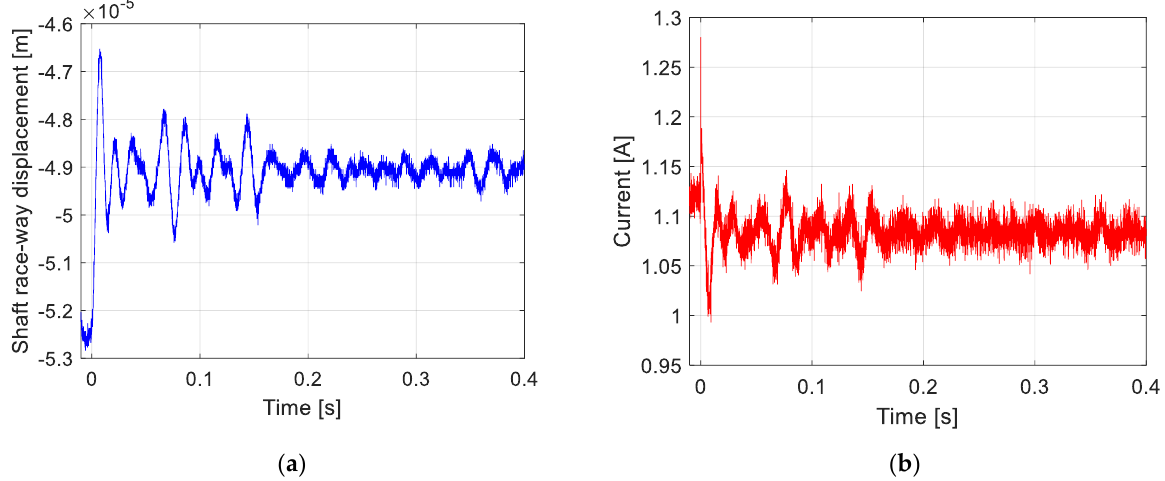
Figure 18. Time histories of the registered quantities: the rotor – shaft raceway displacement ( a ); the control current ( b ).